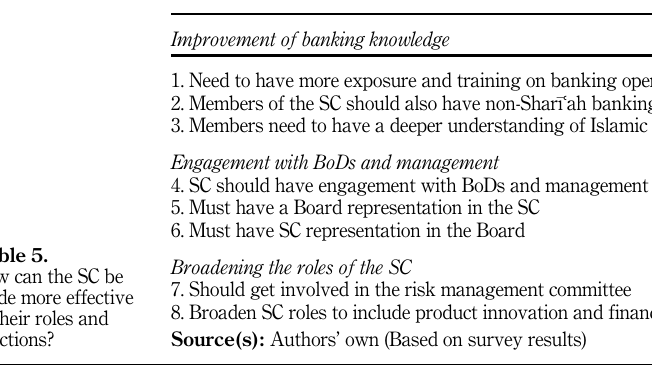
Table 5. How can the SC be made more effective in their roles and